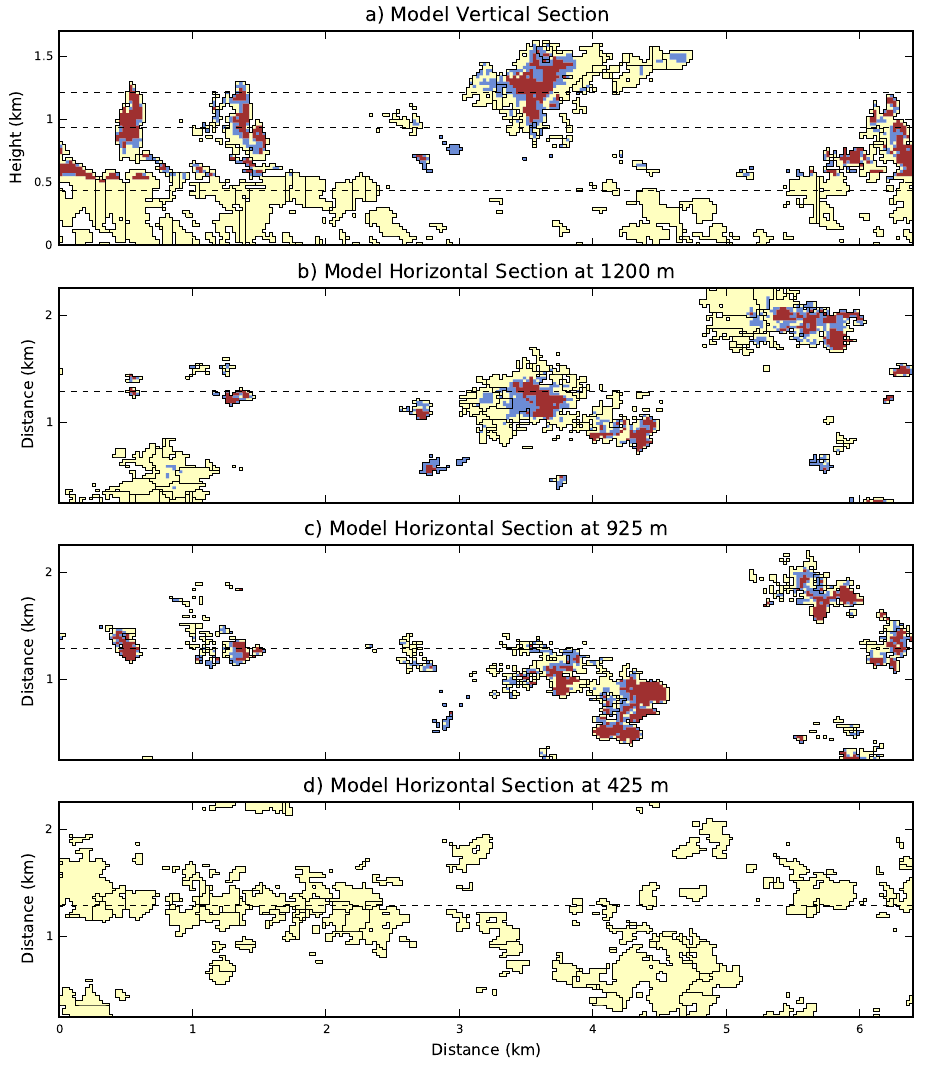
Fig. 1. Vertical and horizontal sections through the BOMEX model, showing the cloud core (dark red), condensed liquid water (blue) and the plume (light yellow) regions used by the cloud tracking algorithm. Black lines show the edges of algorithm cloudlets. (a) Vertical east-west section across the model domain. Dashed lines show the heights of the horizontal sections shown in (b) – (d) . (b) Horizontal section across the model domain at 1200m height. Dashed line shows the position of the vertical section shown in (a) . Only 2km of the 6.4km domain are shown in the north-south direction. (c) Same as for (b) , but at 925m height. (d) Same as for (b) , but at 425m height.